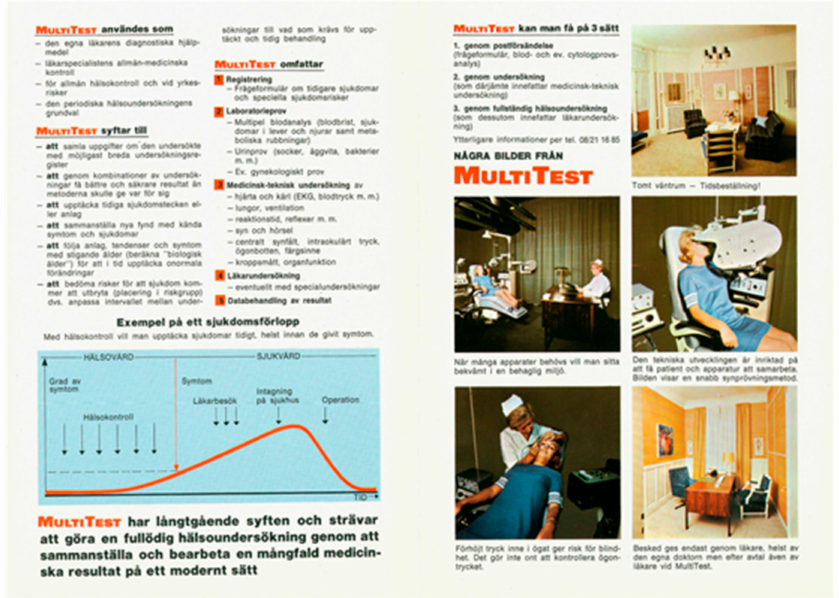
Figure 10. Second page of a flyer for the MultiTest Centre described in the